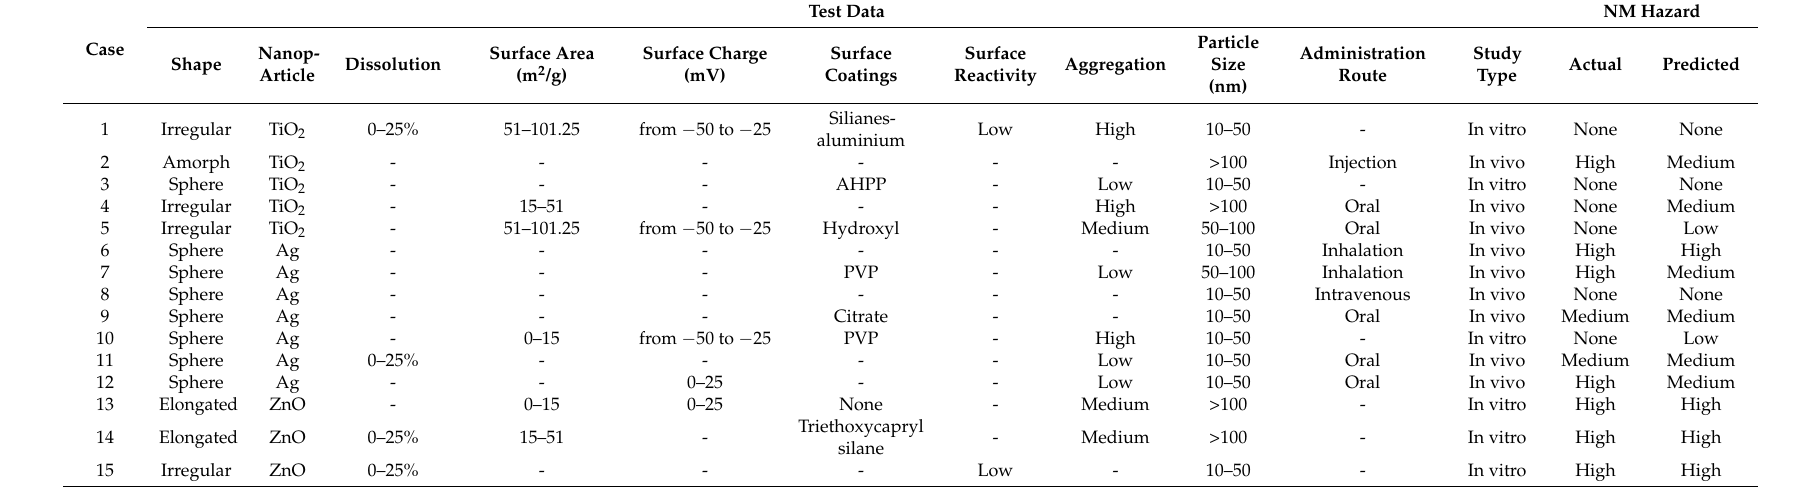
Table 2. Sample (15 cases) results of out-of-sample validation test for